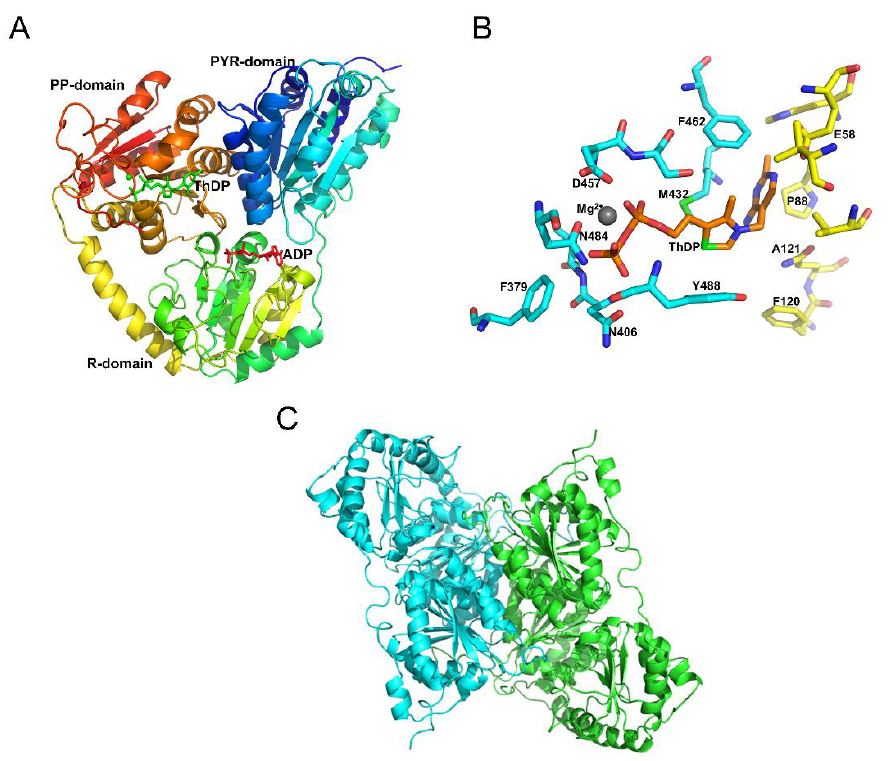
Figure 4. Molecular modeling of AtOXC. ( A ) A modeled structure of AtOXC docked with cofactors ThDP and Mg 2+ ion, and activator ADP. Both ThDP ( green ) and ADP ( red ) are shown as stick models, and Mg 2+ ion is shown as a sphere model in green. ( B ) Binding site of cofactors ThDP and Mg 2+ ion. ThDP is shown as an orange stick model. Selected protein residues within the binding pocket are labeled and shown as stick models in cyan for residues from one subunit and yellow for residues from other subunit, and Mg 2+ ion is shown as a gray sphere model. ( C ) Dimeric model of AtOXC. The two monomers are shown in green and cyan,